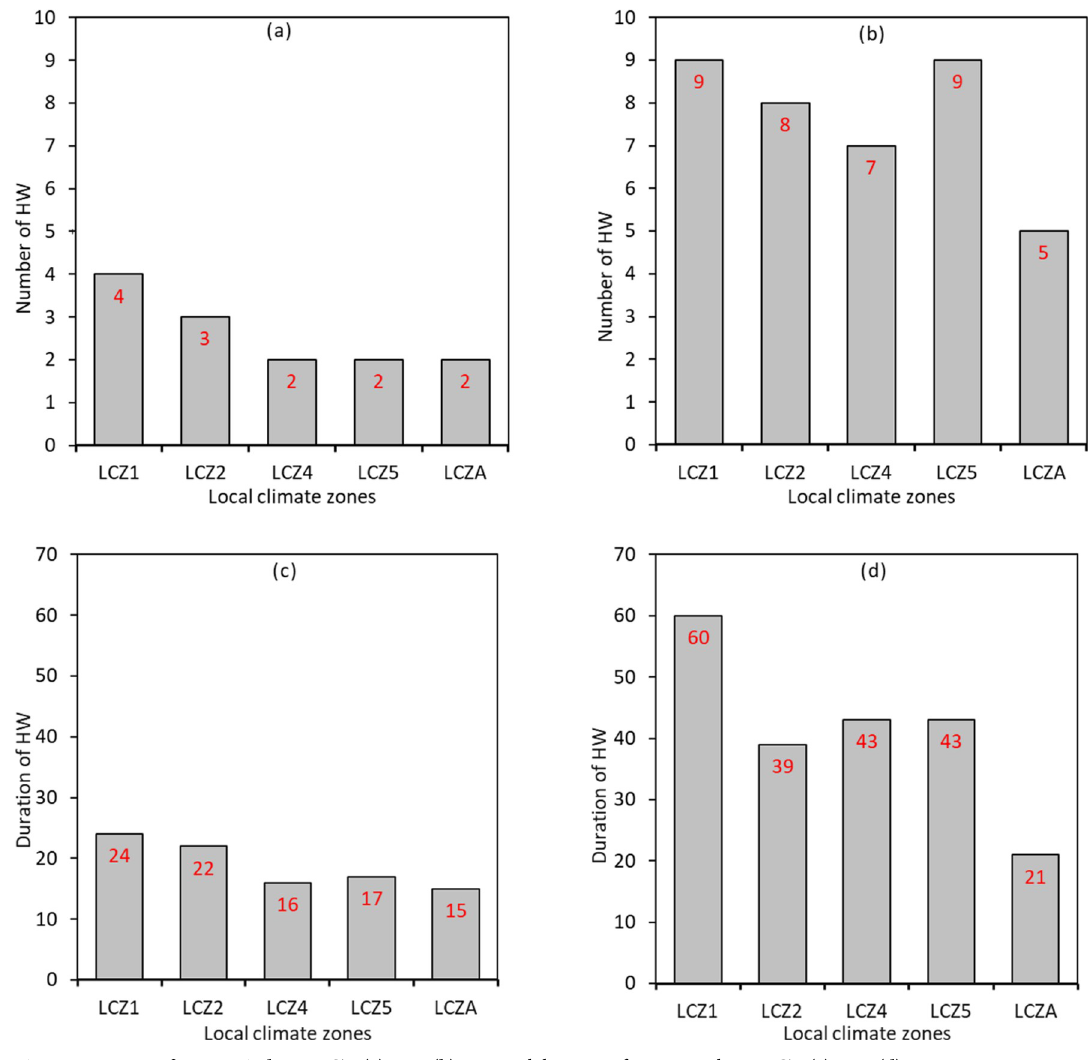
Fig 7. Frequency of HW periods per LCZ. (a) 2012 (b) 2016 and duration of HW periods per LCZ; (c) 2012 (d)